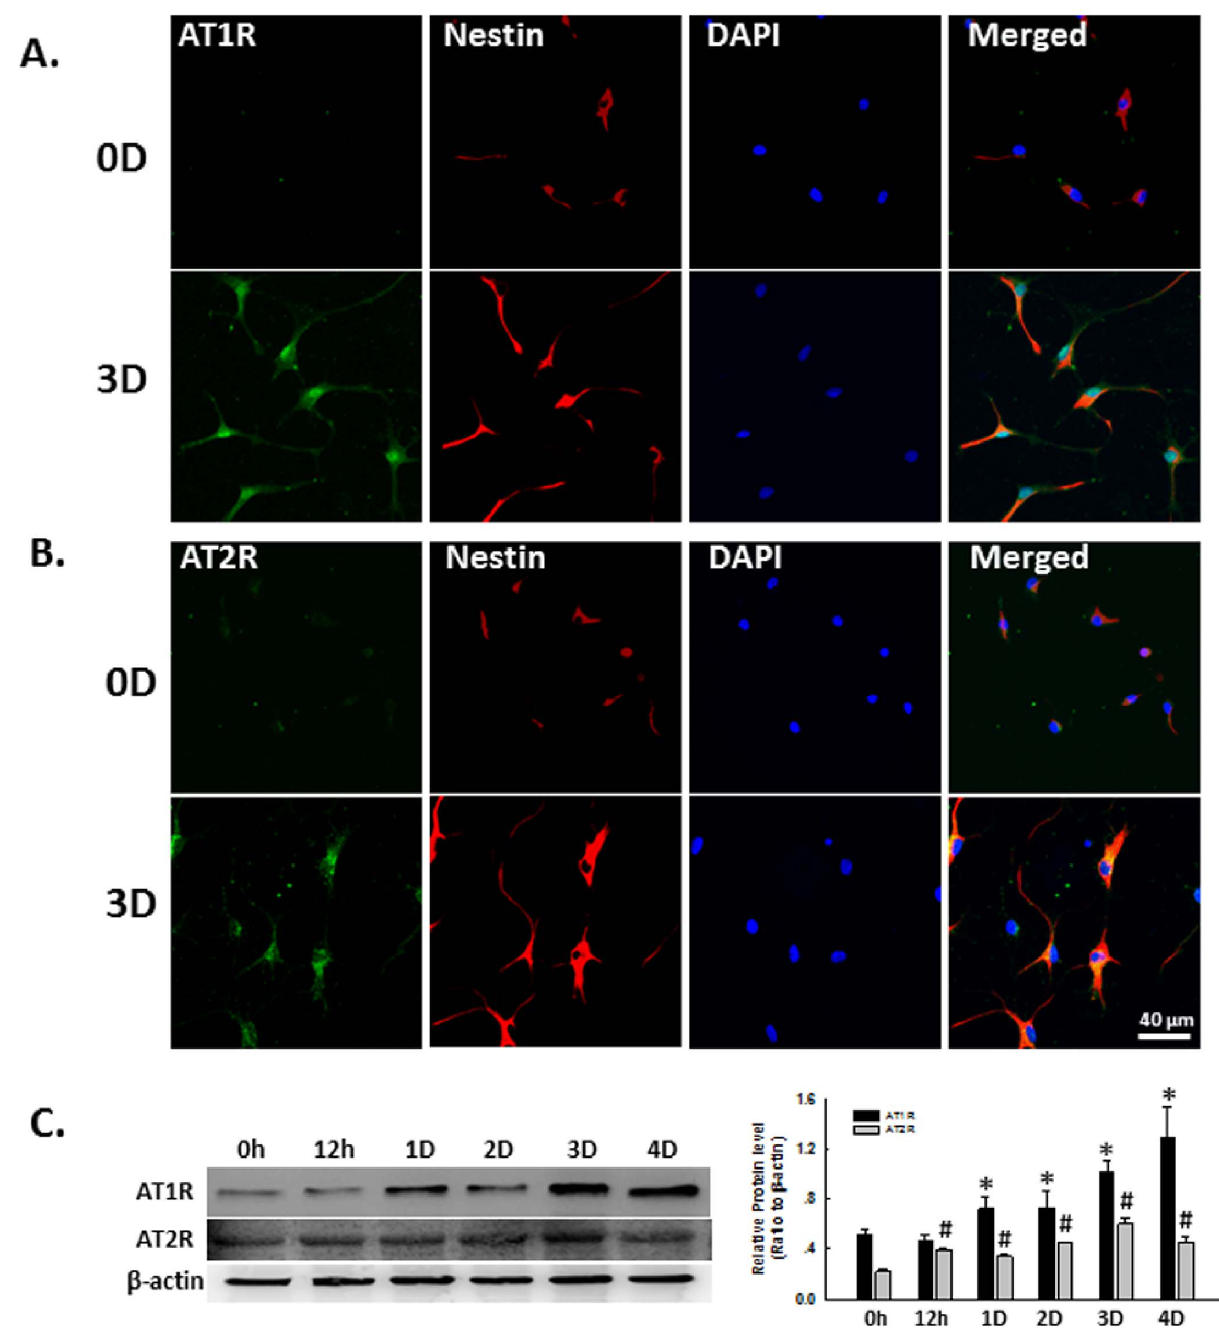
Figure 2. Expression pattern of AT1R and AT2R in NSCs. A) Representative immunofluorescence images showing the AT1R expression in NSCs. 0D: 0 day; 3D: 3 days. NSCs cultured at day 0 or day 3 were fixed with 4% paraformaldehyde followed by immunostaining for nestin (red), a neural stem cell marker, and AT1R (green). DAPI (blue): nuclei marker. Scale bar:40 m m. B) Representative immunofluorescence images showing the AT2R expression in NSCs. NSCs cultured at day 0 or day 3 were fixed with 4% paraformaldehyde followed by immunostaining for nestin (red) and AT2R (green). DAPI (blue): nuclei marker. Scale bar:40 m m. C) Representative blots (left panel) and mean data of relative blot density (right panel) showing expression pattern of AT1R and AT2R in NSCs. Expression of AT1R or AT2R was determined from NSCs cultured for 0 hour, 12 hours, 1 day, 2 days, 3 days and 4 days by Western Blot analysis. *P , 0.05 vs AT1R expression in NSCs cultured at 0 hour; # P , 0.05 vs AT2R expression in NSCs cultured at 0 hour, n=3 in each group. doi:10.1371/journal.pone.0063488.g002 to electrophoresis on a 12% sodium dodecyl sulfate-ployacryla- Western Blotting minde (SDS) gel and blotted onto a polyvinylidene difluoride NSCs were lysed using the Mammalian Cell Lysis kit (Sigma, St. membrane with a semi-dry blotting apparatus. After blocking, Louis, MO). Cell lysis containing 20 m g of protein were subjected